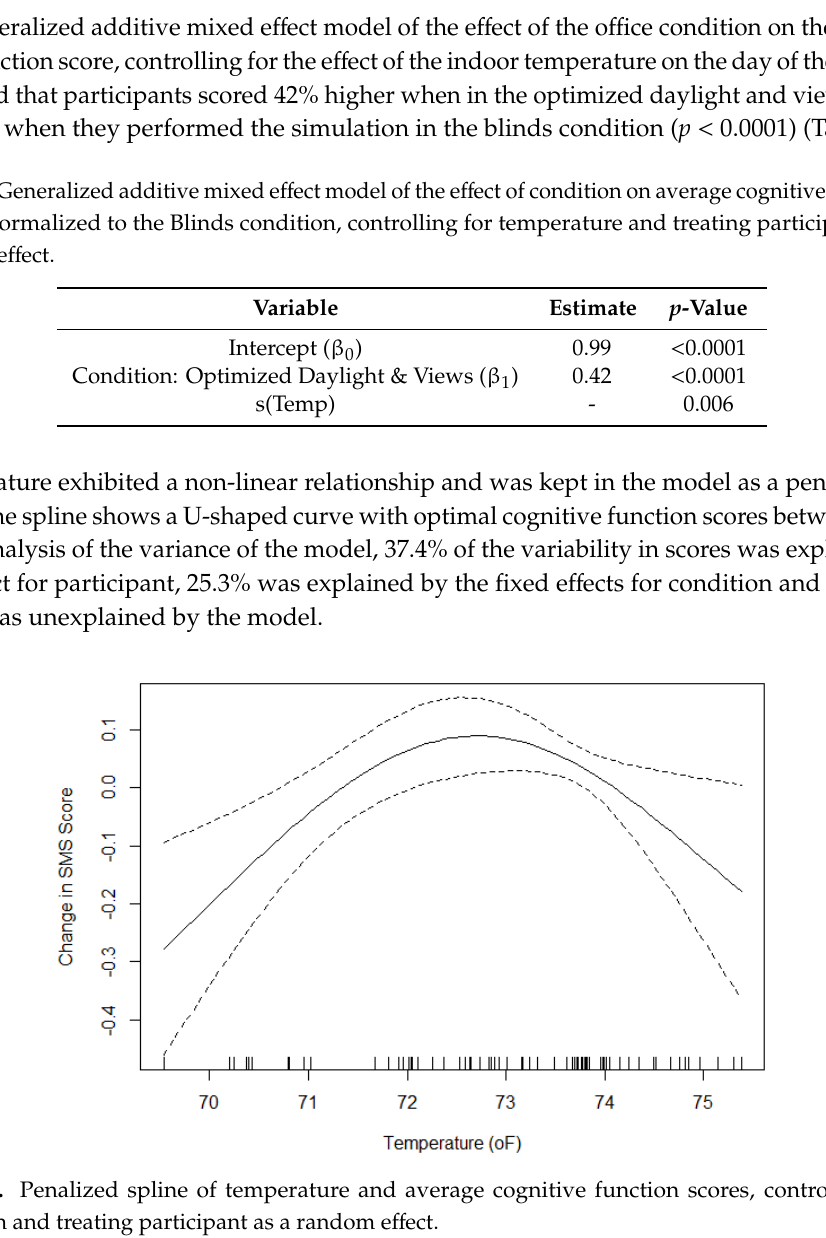
Figure 7. Penalized spline of temperature and average cognitive function scores, controlling for condition and treating participant as a random e ff condition and treating participant as a random effect.